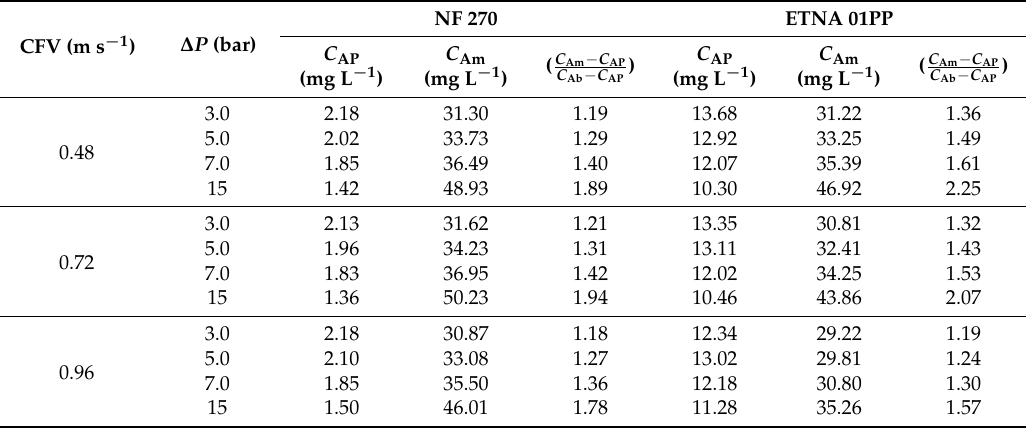
Table 4. Assessment of concentration polarization by phenolic compounds at different cross flow velocities (CFV) and transmembrane pressure ( ∆ P ) for NF 270 and ETNA 01PP